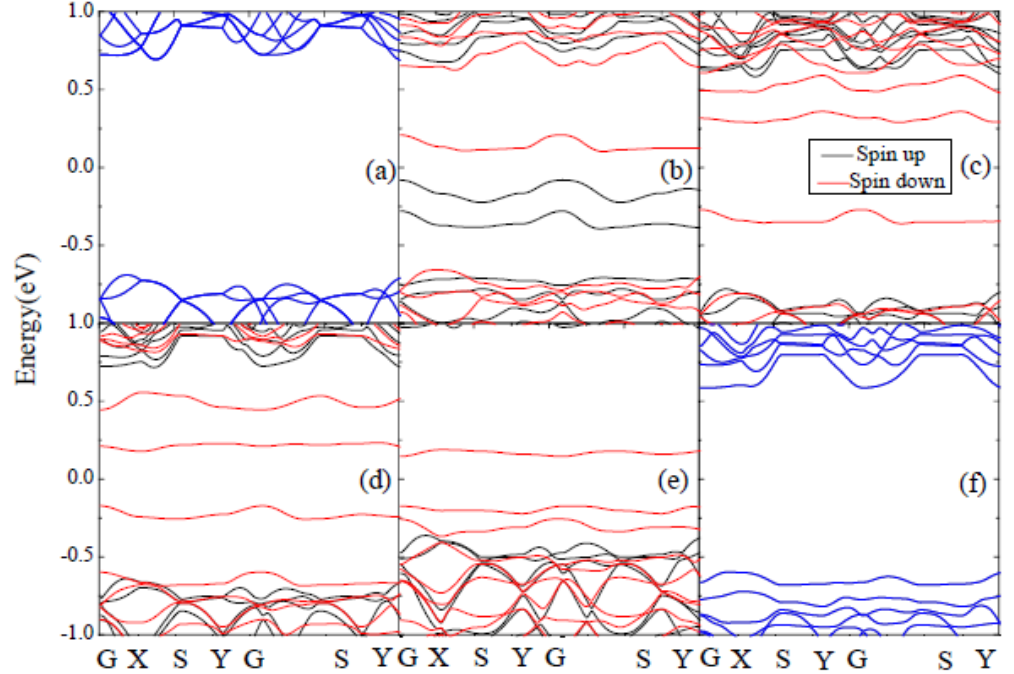
Figure 3. Electronic band structures of different doped systems, ( a ) pristine system, ( b ) Cr-doped system, ( c ) Mn-doped system, ( d ) Fe-doped system, ( e ) Co-doped system, ( f ) Ni-doped system, respectively. The electronic states near the Fermi level (E F ) have great influence on the electron